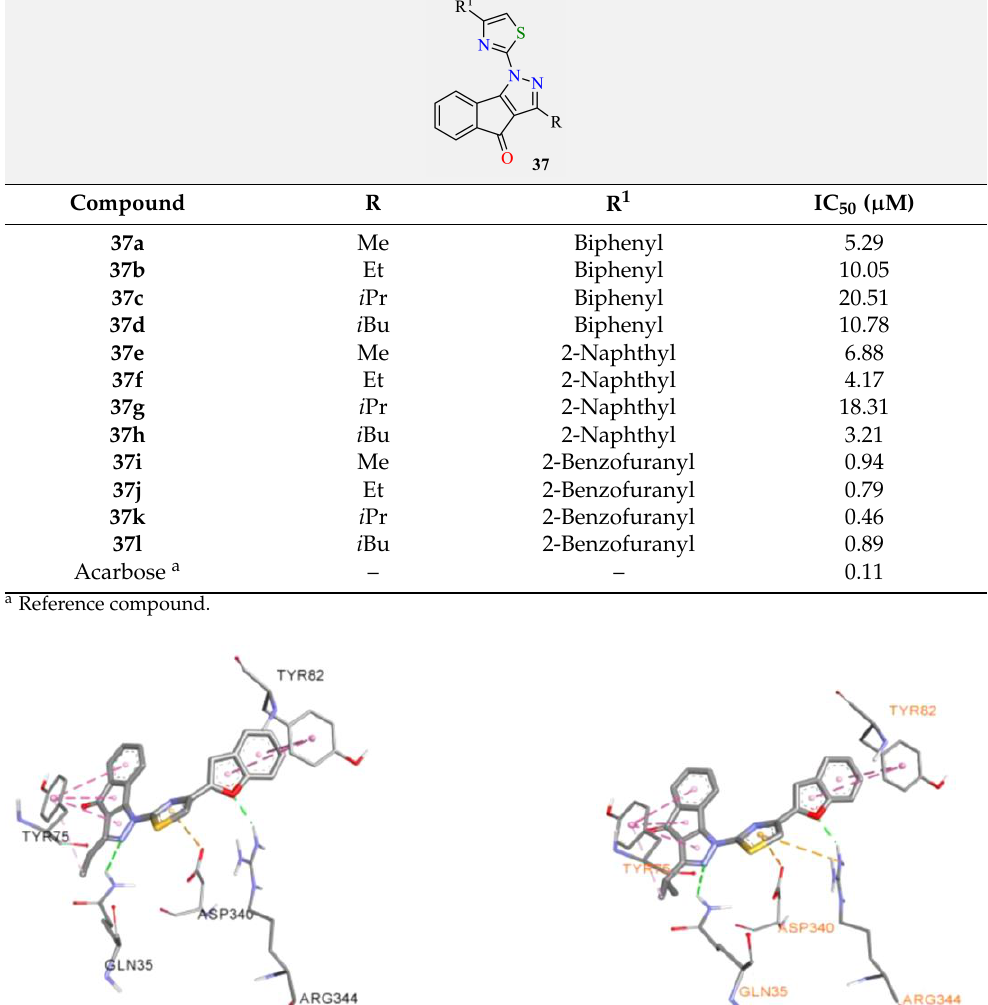
Figure 13. 3D Interactions of indenopyrazoles 37j (left) and 37k (right) with binding sites of Aspergillus oryzae α -amylase (PDB ID: 7TAA). Image adapted from Mor et al. [36].